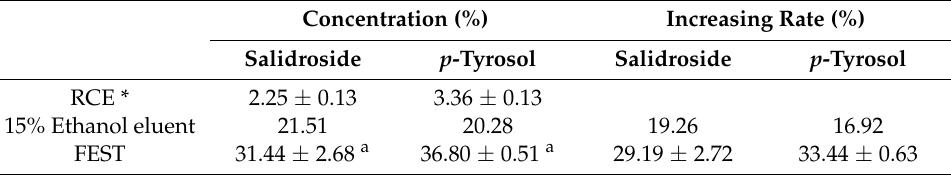
Figure 2. UPLC profiles for purification of salidroside and p -tyrosol with DIAION HP-20 adsorbent resin. Shown in sequence are profiles of salidroside standard ( A ), p -tyrosol standard ( B ), R. crenulata crude extract (RCE) ( C ), water eluent ( D ), 15% ethanol eluent ( E ), 25% ethanol eluent ( F ), and fraction enriching salidroside and p -tyrosol, i.e., FEST ( G ). Ordinates of ( C – G ) were proportionally adjusted for comparison. Sal and Tyr refer to salidroside and p -tyrosol, respectively. Table 1. Effects of DIAION HP-20 adsorbent resin on purification of salidroside and p